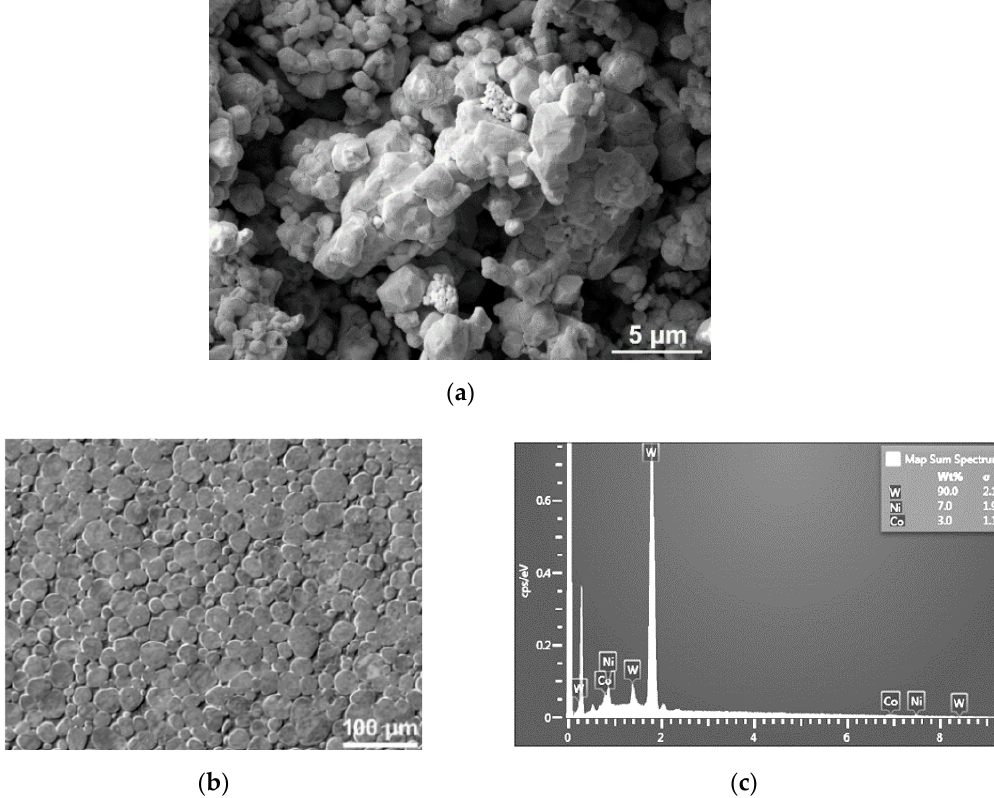
Figure 6. SEM-SE image of initial powder mixture ( a ); SEM-SE scan of the area’s chemical composition from which was analyzed ( b ) the element spectrum corresponding to area presented in Figure 6b ( c ).